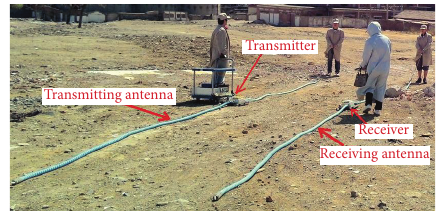
Figure 7: The typical configuration for the low-frequency coded GPR.